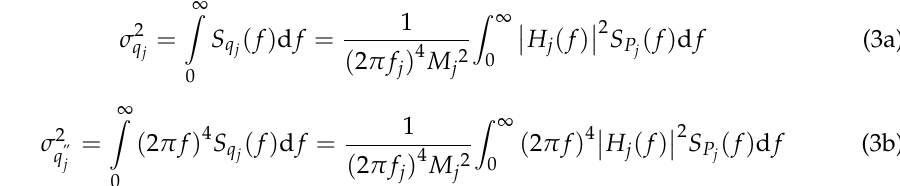
( b ) Figure 7. Standard deviations of displacements in different azimuths: ( a ) x -direction. ( b ) y -direc- tion. 4.2. Wind-Induced Base Overturning Moments In addition to acceleration and displacement, the wind-induced responses of the structure also contain overturning moments. The base overturning moments consist of three parts: the mean load, the background component, and the inertia component in- duced by the building’s motions [2,11]. The correlation between the background compo- nent and the inertia component is weak. Therefore, the square root of the sum of the squares (SRSS) can be used for the combination [27]. The mean loads and the background component can be directly obtained from the tests, whereas the inertia part of the over- turning moments can be obtained as: '' 0 ( ) ( ) H I q M m z z zdz σ= Φ 